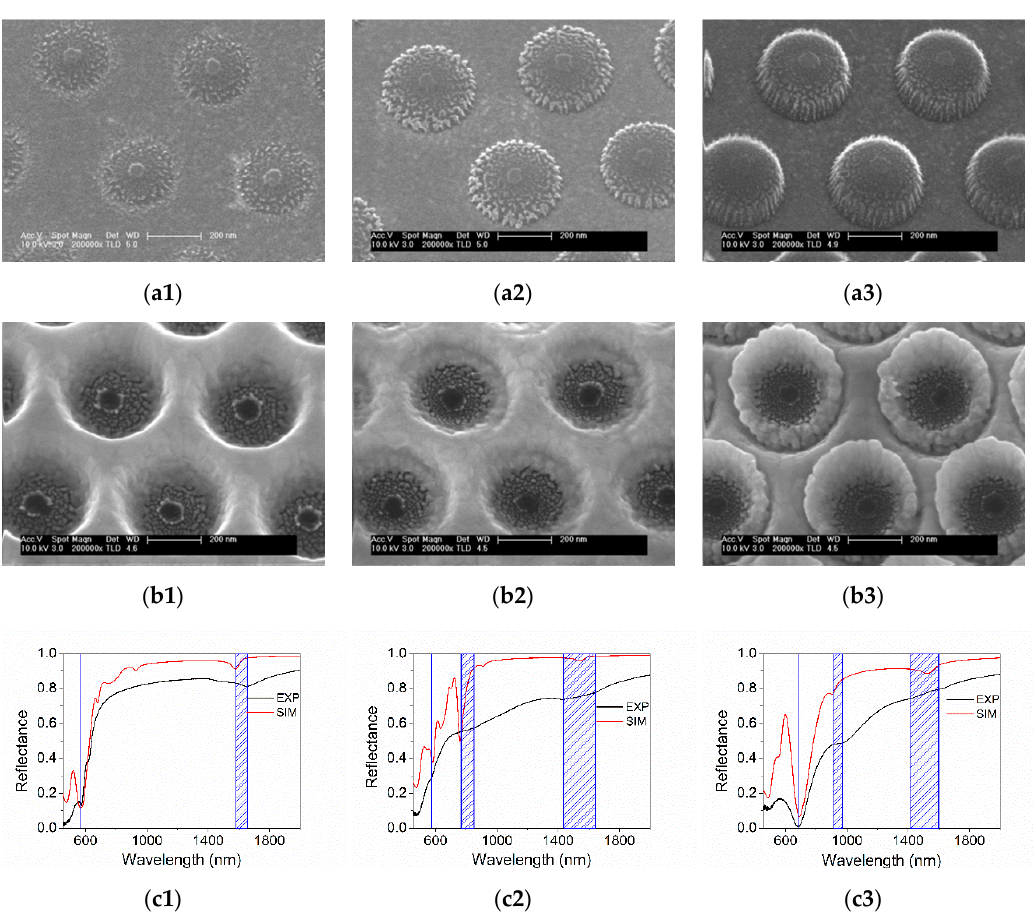
Figure 3. SEM image of the polymeric pillar ( a ) and of the gold nanocavities ( b ) for the Sample 1, 2 and 3, respectively. ( c ) Experimental (black line) and calculated (red line) reflectance spectra for the Sample 1, 2 and 3, respectively. Blue lines and shadowed regions identify the peculiar spectral features.